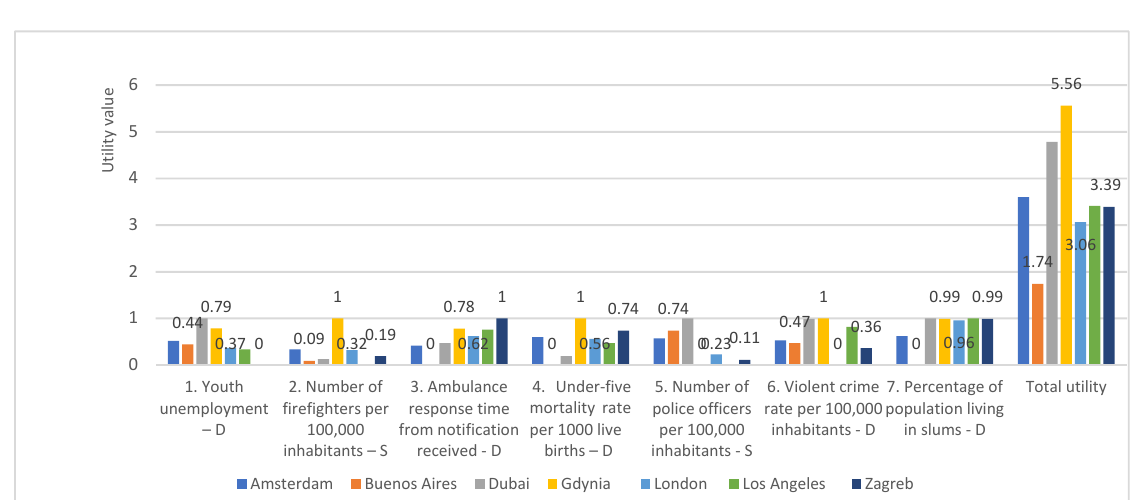
Figure 3. Partial and total utility for the social dimension indicators.